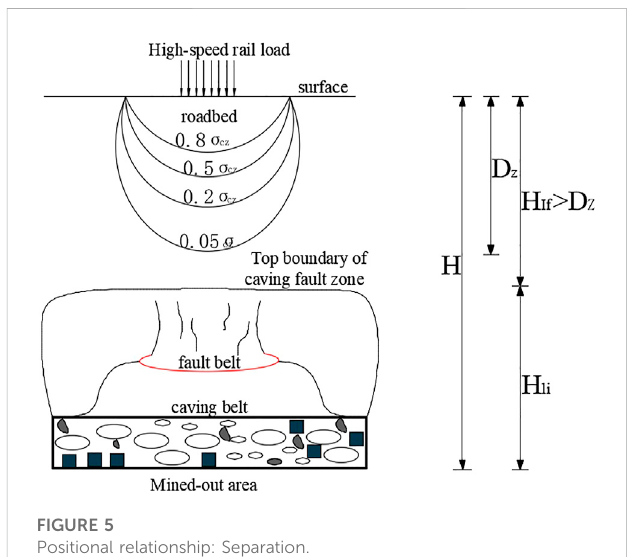
FIGURE 5 Positional relationship: